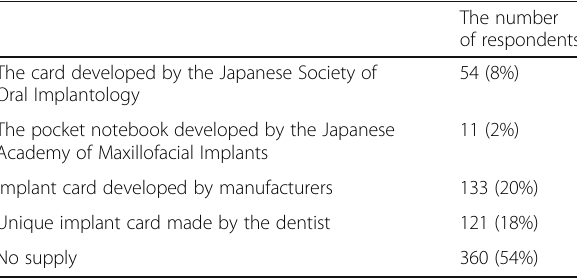
Table 8 Survey of dentists who offer implant treatment (671 dentists). “ Do you use the implant card?